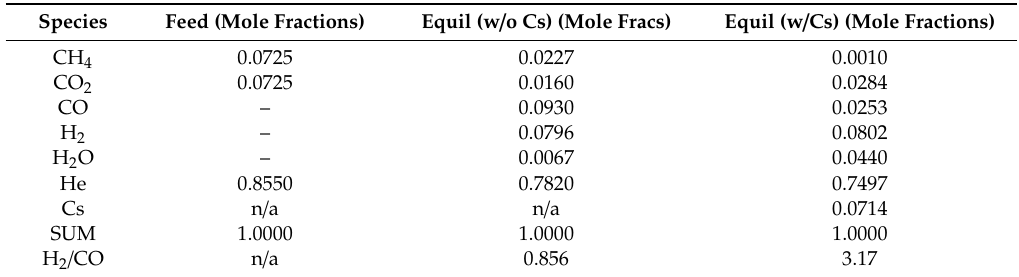
Table 2. Impact of solid carbon (Cs) on equilibrium; T = 973 K, P = 3.03 × 10 5 Pa, initial CH 4 / CO 2 = 1.